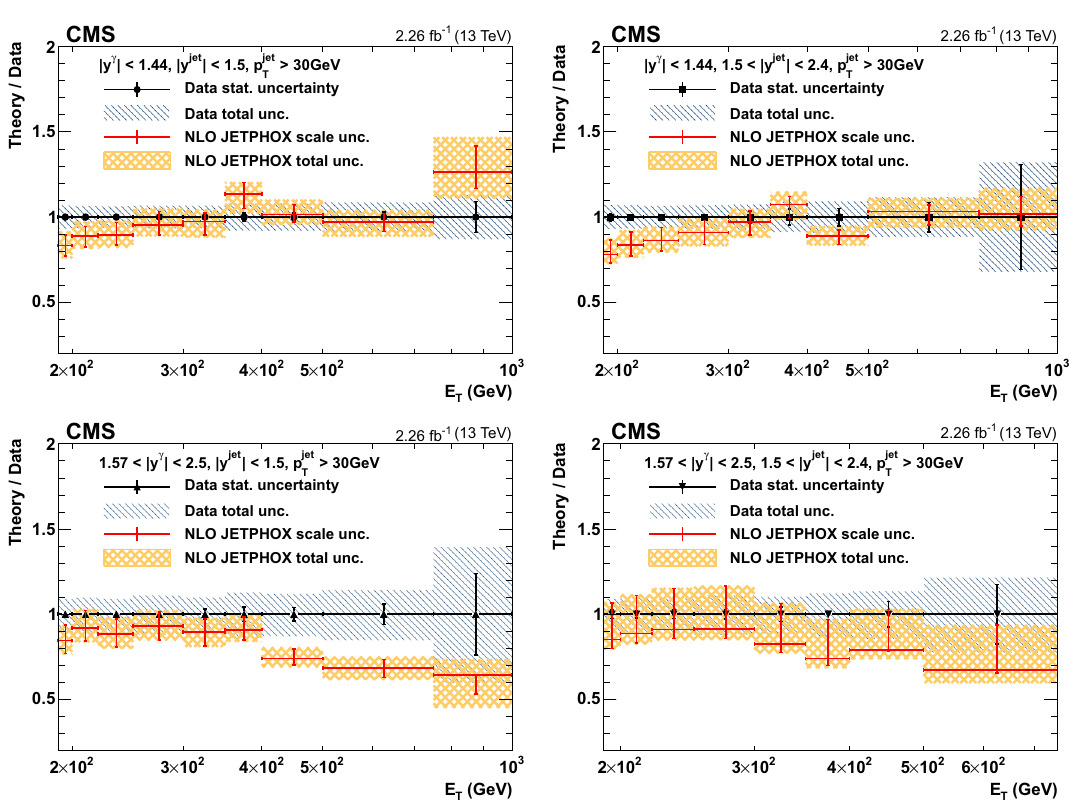
Fig. 6 The ratios of theoretical NLO prediction to data for the differ- ential cross sections for photon+jet production in two photon rapidity ( | y γ | < 1 . 44 and 1 . 57 < | y γ | < 2 . 5) and two jet rapidity ( | y jet | < 1 . 5 and1 . 5 < | y jet | < 2 . 4)bins,areshown.Theerrorbarsonthedatapoints